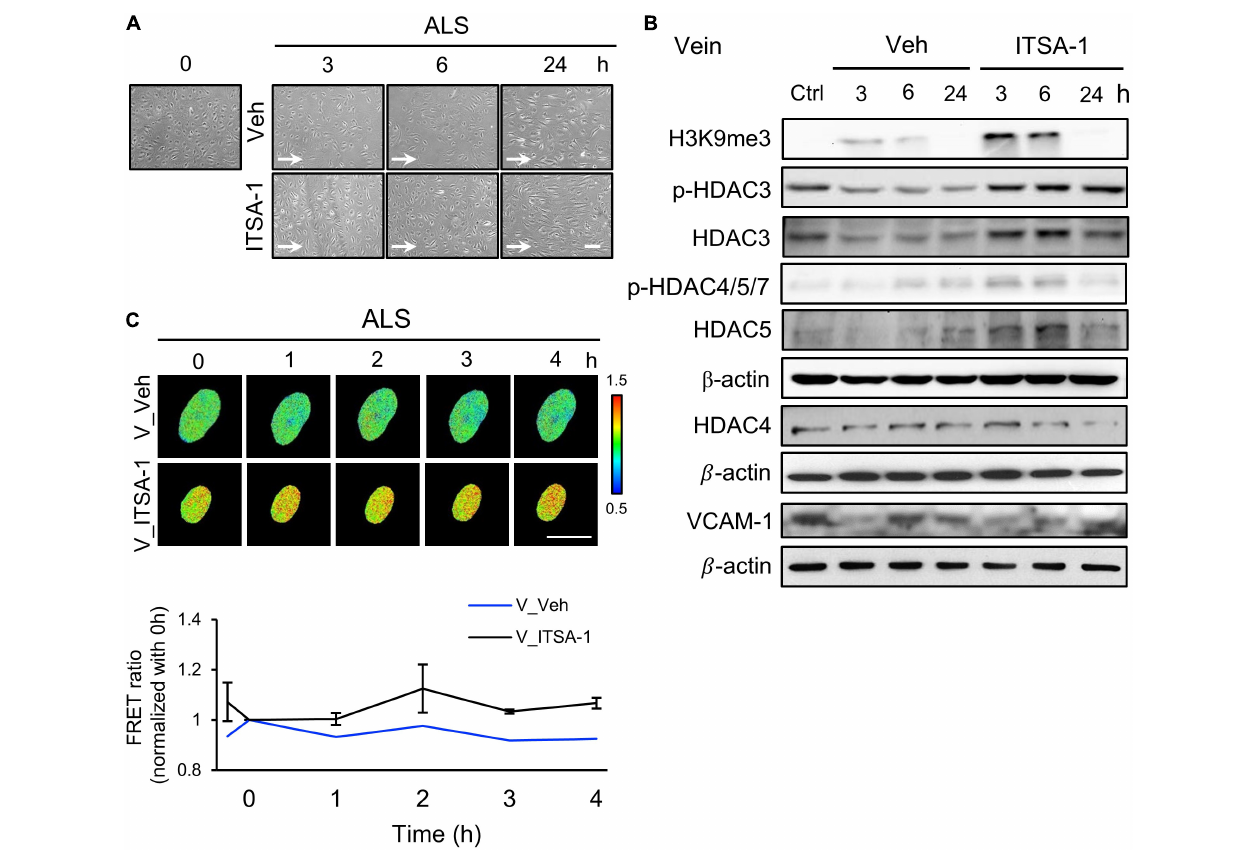
FIGURE 4 | Reverse the ALS-induced inflammation by ITSA-1 in vEC. (A) The cell images of 150 µ M ITSA-1- or vehicle-treated vECs (HSVECs) were shown under ALS for 0, 3, 6, and 24 h. The ITSA-1-treated HSVECs were significantly aligned parallel to the flow direction of ALS at 24 h. (B) Protein expression was analyzed by using Western blotting assay against H3K9me3, p-HDAC3, p-HDAC4,5,7, HDAC3, HDAC4, HDAC5, and VCAM-1. ITSA-1-treated HSVECs reduced the VCAM-1 expression by increasing the HDAC3, p-HDAC4, 5, 7, and H3K9me3 as compared to the vehicle group after exposed to ALS at 3 and 6 h. (C) The level of H3K9me3 was raised in the ITSA-1 group but not in vehicle group under ALS in H3K9me3 FRET biosensor-transfected HSVECs. Scale bar in (A) = 200 µ m. Scale bar in (C) = 20 µ m. Data were represented as mean ± SEM. Arrow indicated the flow direction of ALS (left to